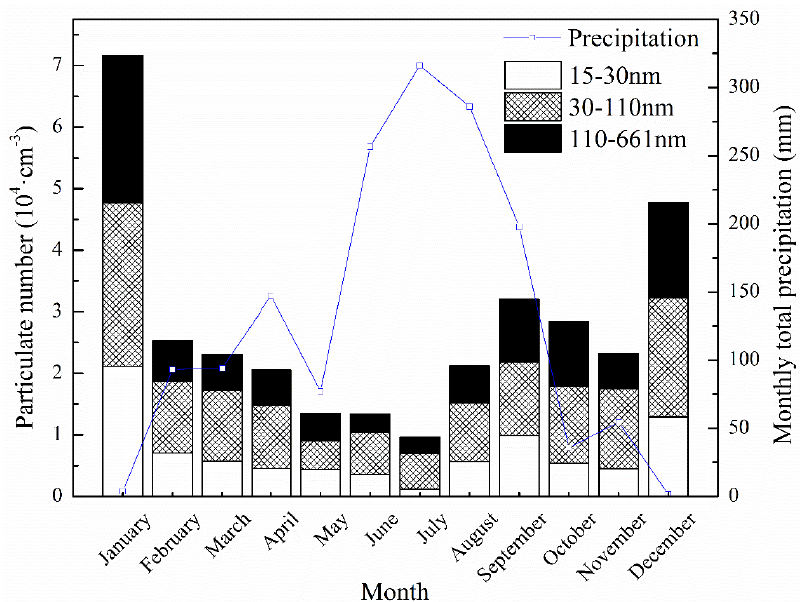
Figure 3. Monthly averaged number concentration of particles in three modes and monthly pattern of precipitation.